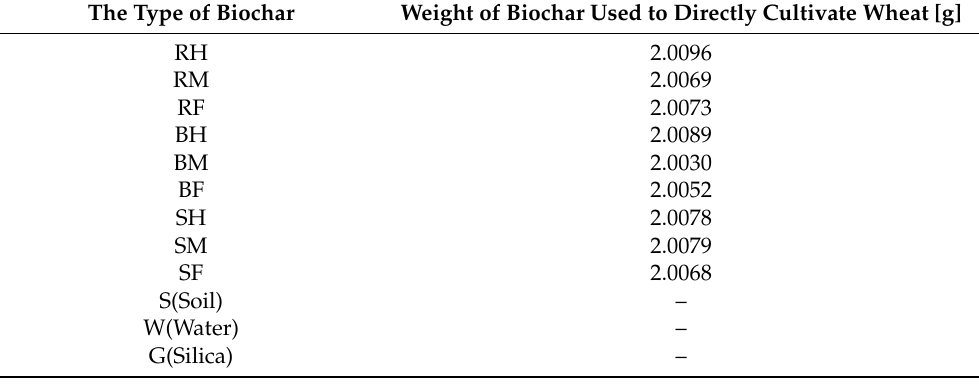
Table 4. The weight of biochar prepared by FW for wheat culture.